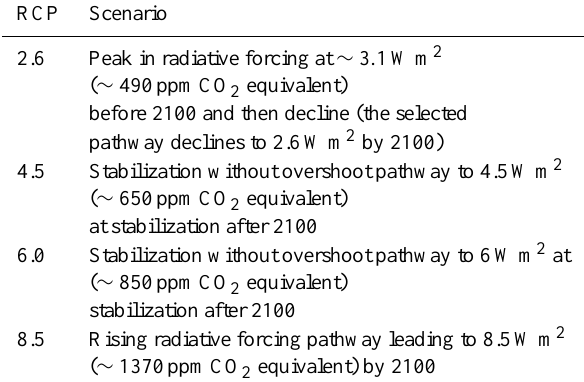
(RCPs) (Van Vuuren et al., 2011). Radiative forcing values include the net effect of all anthropogenic greenhouse gases and other forc- ing